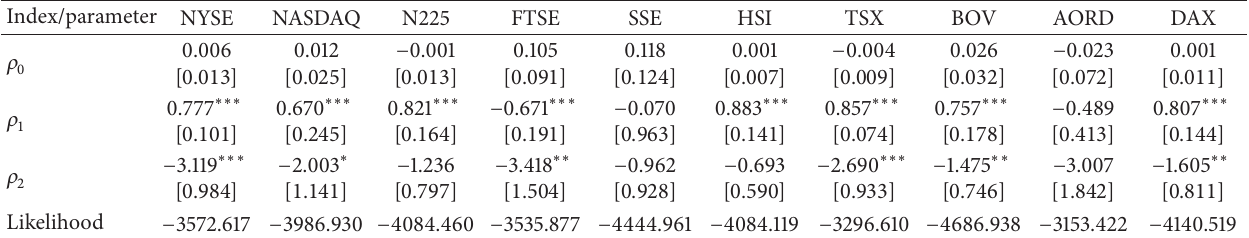
Table 7: Results of TVRA-GARCH-M model